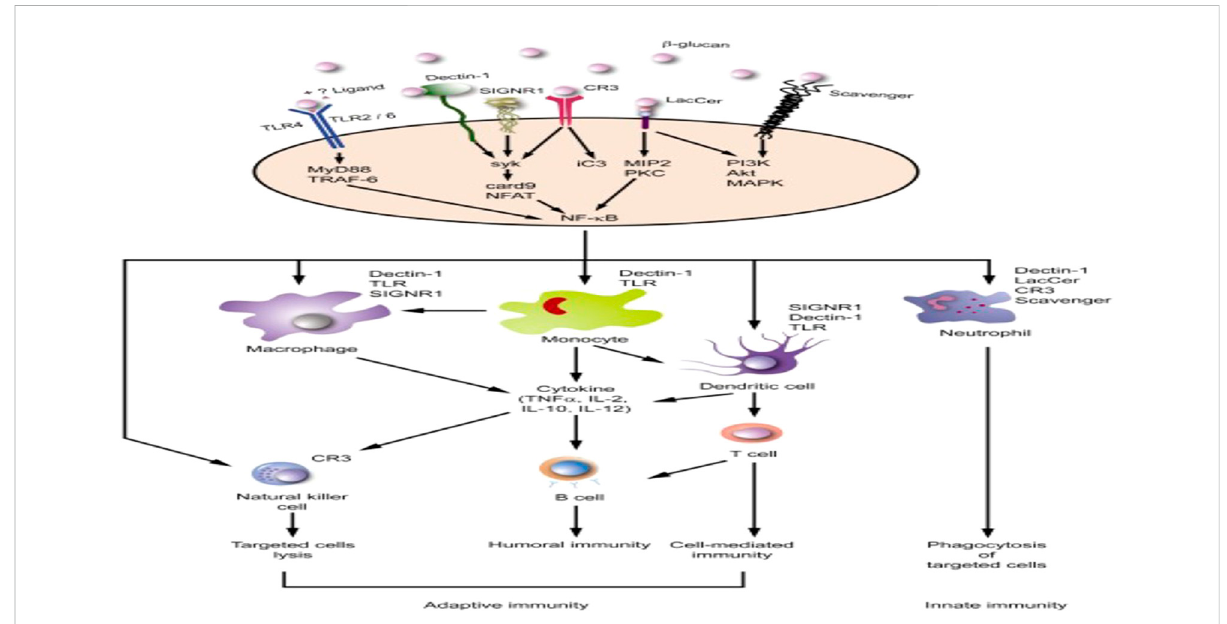
FIGURE 4 Activation induction of immune system by β -glucans (Rasjidi and Susanto,